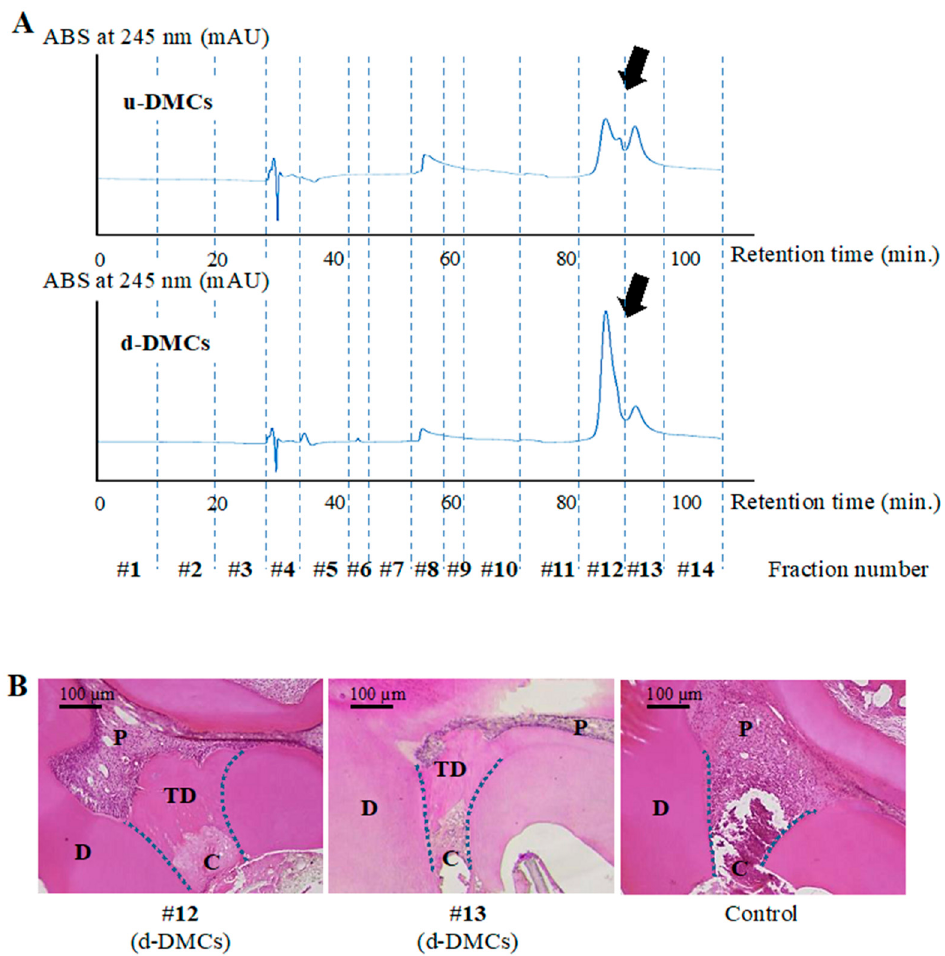
Figure 1. Peak analysis by reverse-phase high performance liquid chromatography (RP-HPLC) and direct pulp capping experiments for screening. ( A ) Chromatographic analysis of untreated dentin matrix components (u-DMCs) and digested DMCs (d-DMCs). Arrows indicate different shaped peaks between the samples. Each sample was divided into 14 fractions. ( B ) Histological images of tertiary dentin formation at 28 days after direct pulp capping using fractions #12 or #13 of d-DMCs or the control (D = primary dentin, TD = tertiary dentin, P = pulp, and C = cavity). Images are representative of three independent experiments.